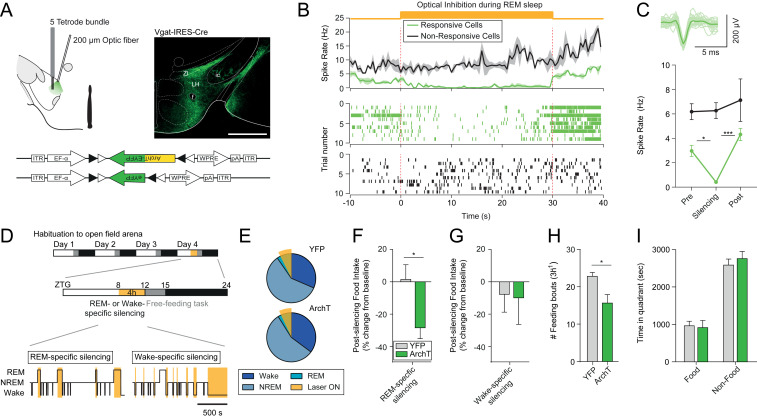
Optogenetic silencing of LHvgat neurons during REM sleep, but not wakefulness, decreases food intake. (A) Schematic of optogenetic targeting and tetrode recordings from freely moving mice (Left). Photomicrograph shows cell-specific expression of ArchT in the LH of vgat-IRES-Cre mice (Right). LHvgat neurons were transfected to either express ArchT-eYFP (test group) or eYFP only (control group, Lower). fx, fornix; ic, internal capsule; LH, lateral hypothalamus; ZI, zona incerta. (Scale bar, 500 μm.) (B) Average spike rate ± SEM of light-responsive and nonresponsive single units from the LH (Top). Continuous light illumination (532 nm, orange shading) was delivered for 30 s during REM sleep. Raster plots from a representative light-responsive (Middle) and a nonresponsive (Bottom) unit are shown across the illumination period. (C) Average waveform of a responsive unit (Upper). The mean spike rate of the light-responsive (n = 8 cells) and nonresponsive (n = 10 cells) units before, during, and after the silencing is shown (Lower, n = 4 animals). Two-way RM ANOVA, FResponsive(1,
16) = 12.69, FStim(2,
32) = 7.24, FResponsive
x
Stim(2,
32) = 3.49 with Tukey’s post hoc test, *P < 0.05, ***P < 0.001. (D) Timeline of optogenetic silencing experiment (Top). Mice were habituated to the open field arena for 3 d prior to testing. Online optogenetic silencing (Middle) was conducted between zeitgeber (ZTG) 8 and 12, and food-directed behaviors were quantified in a free-feeding task over the next 3 h (ZTG 12–15). Continuous optical stimulation (orange shading) was delivered selectively during REM sleep (Bottom Left) or wake (Bottom Right) episodes to silence LHvgat neurons in a state-specific manner. (E) Average percentage of vigilance states during the REM-specific optogenetic silencing experiment for YFP control (n = 8 animals, Upper) and ArchT (n = 8 animals, Lower) mice. The orange shading indicates total optogenetic stimulation time during REM sleep. Two-way ANOVA, P > 0.05. (F) Average postsilencing food intake change ± SEM after REM sleep-specific silencing in YFP control (gray, n = 8 animals) and ArchT (green, n = 8 animals) mice. Student’s unpaired t test, t14 = 2.68, *P < 0.05. (G) Average postsilencing food intake change − SEM after wake-specific silencing in YFP control (gray, n = 5 animals) and ArchT (green, n = 7 animals) mice. Student’s unpaired t test, P > 0.05. (H) Average feeding frequency + SEM over the free-feeding task following optogenetic silencing during REM sleep in YFP control (gray, n = 6 animals) and ArchT (green, n = 5 animals) mice. Student’s unpaired t test, t9 = 3.05, *P < 0.05. (I) Average time + SEM spent in food and nonfood quadrants of the open field arena after REM sleep-specific silencing for YFP control (gray, n = 6 animals) and ArchT (green, n = 5 animals) mice. Two-way ANOVA, FZone(1,
8) = 2.60, with Sidak’s post hoc test, P > 0.05.